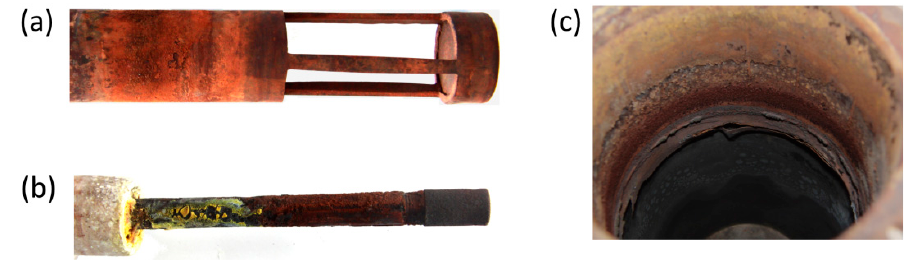
Figure 18. Images of individual construction parts of Model II after the long-term test: ( a ) anode, ( b ) cathode, ( c ) electrolyte crucible.